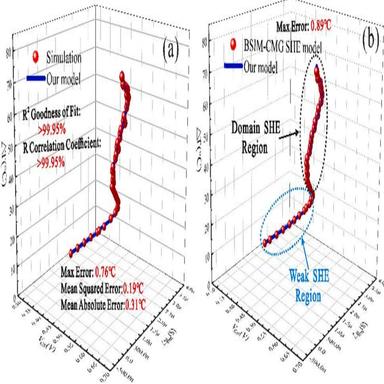
(a) Comparison diagram between simulation results and model calculation results; (b) The calculation results of the BSIM-CMG SHE model and the model proposed in this article.